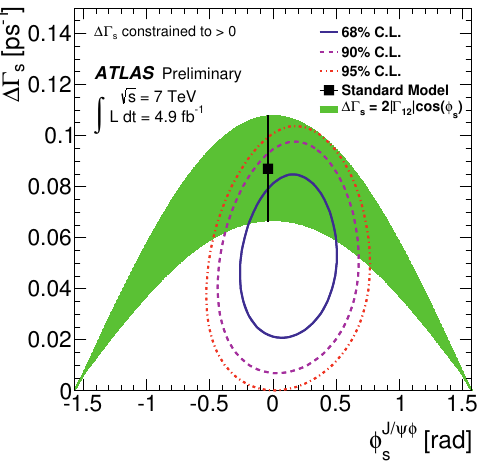
Figure 5. Likelihood contours in φ s - ΔΓ s plane. The blue and red contours show the 68% and 95% likelihood contours, respectively (statistical errors only). The green band is the theoretical prediction of mixing- induced CP violation